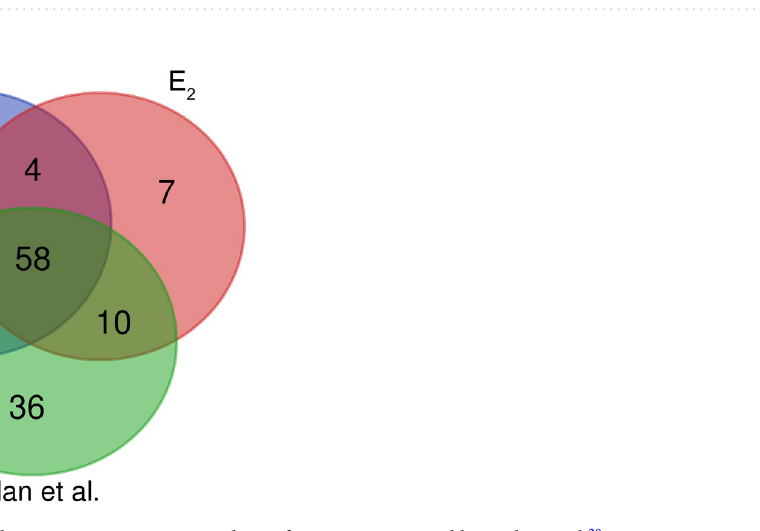
Table 6. Essential proteins associated with COVID-19 pathology.